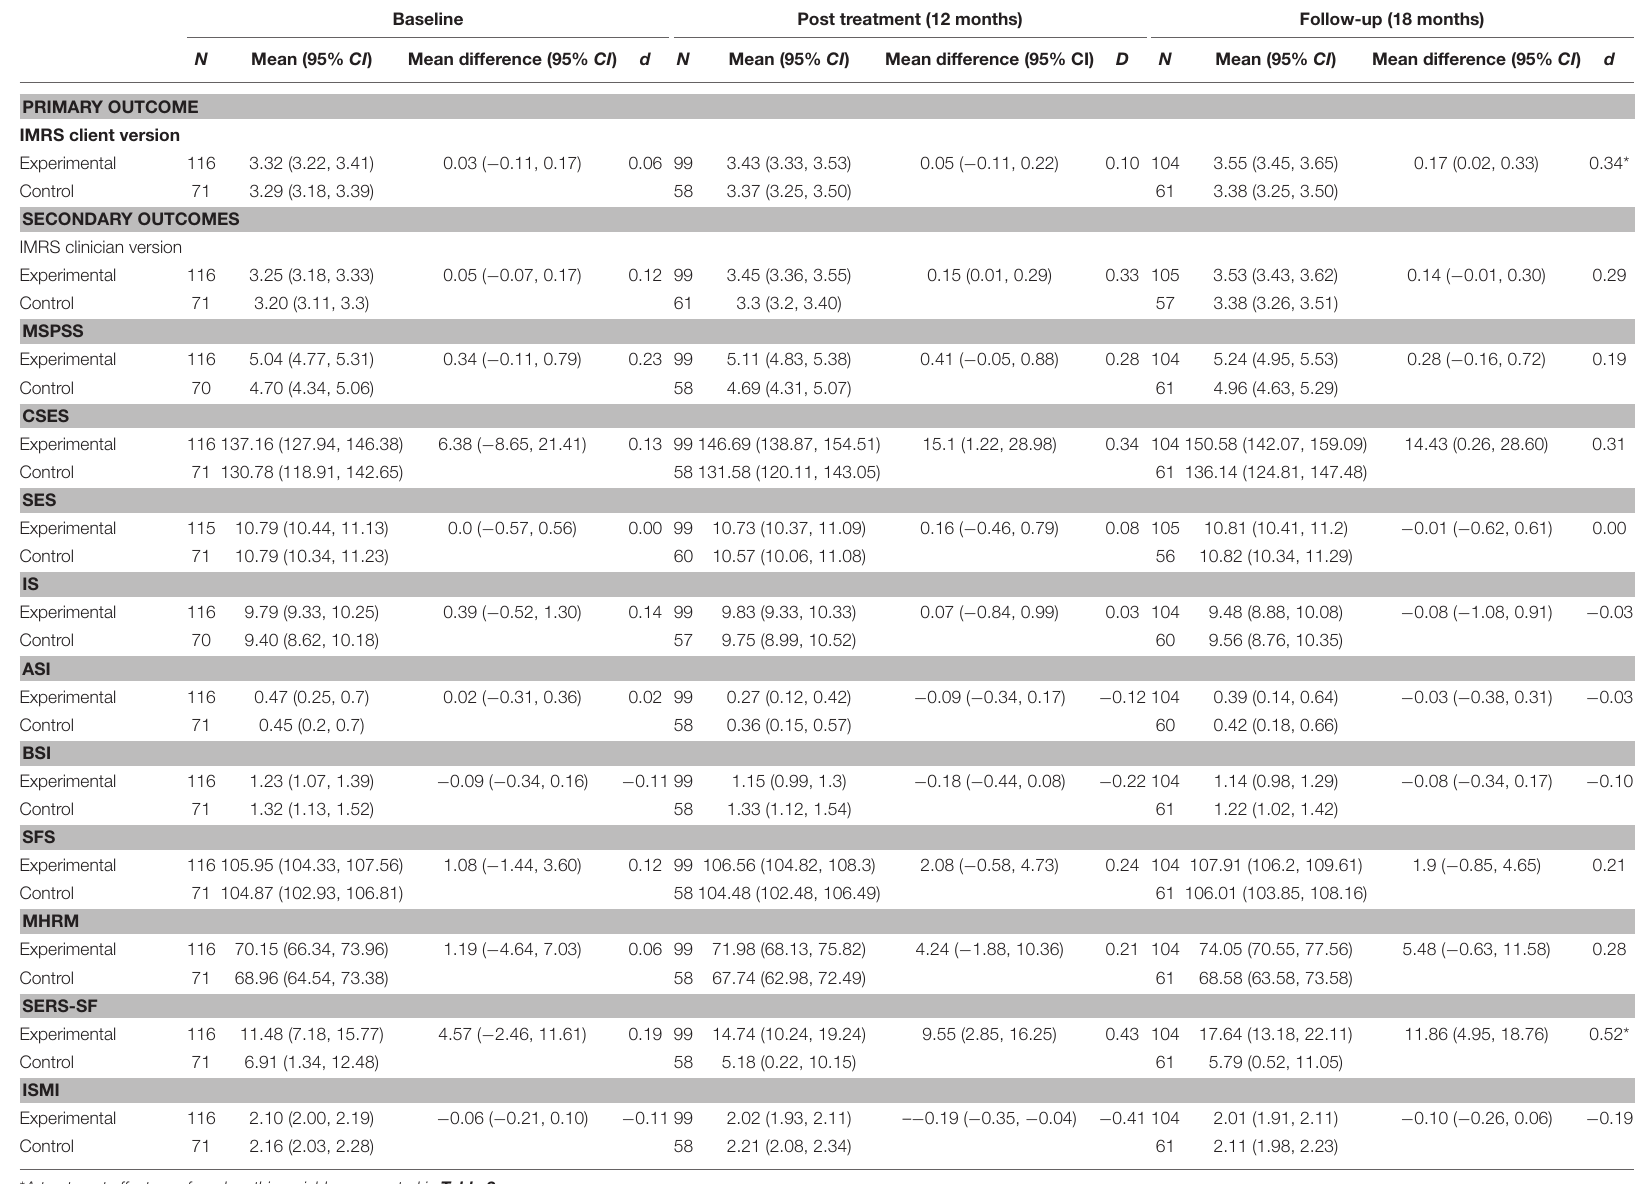
TABLE 3 | Estimated outcomes as a function of IMR, estimated from linear mixed models in the Intention to treat sample. Baseline Post treatment (12 months) Follow-up (18